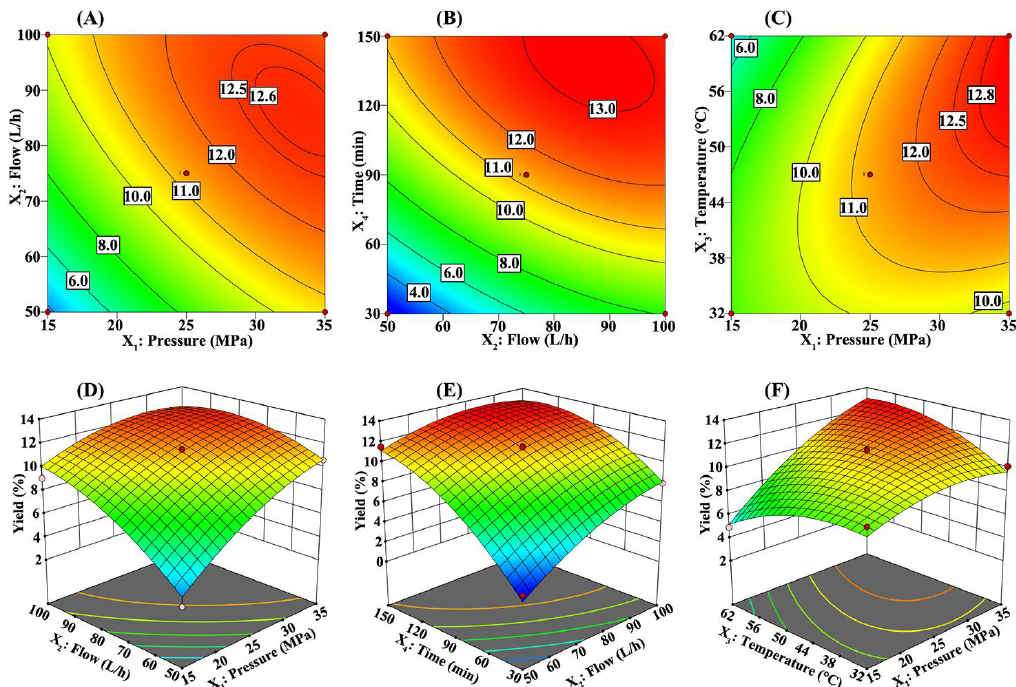
Figure 2. Two-dimensional (2D) contour graphs and three-dimensional (3D) surface graphs of the significant interaction items in the response surface model. ( A , D ) 2D contour graphs and 3D surface graphs showing the effects of pressure (X 1 ) and flow (X 2 ) on the yield at fixed temperature (X 3 = 47 °C) and time (X 4 = 90 min), respectively. ( B , E ) 2D contour graphs and 3D surface graphs showing the effects of flow (X 2 ) and time (X 4 ) on the yield at fixed pressure (X 1 = 25 MPa) and temperature (X 3 = 47 °C), respectively. ( C , F ) 2D contour graphs and 3D surface graphs showing the effects of pressure (X 1 ) and temperature (X 3 ) on the yield at fixed flow (X 2 = 75 L/h) and time (X 4 = 90 min), respectively.